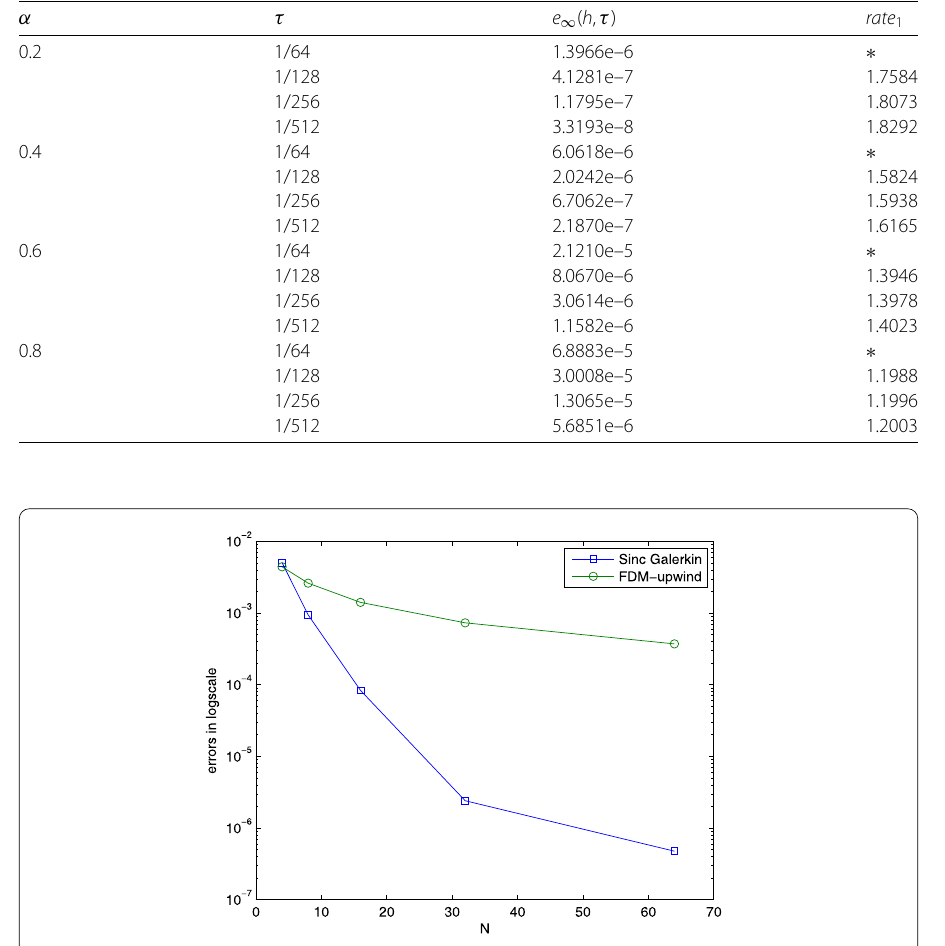
Figure 1 Convergence of the sinc-Galerkin and FDM-upwind methods for various values of N with α = 0.8, τ = 1/4000